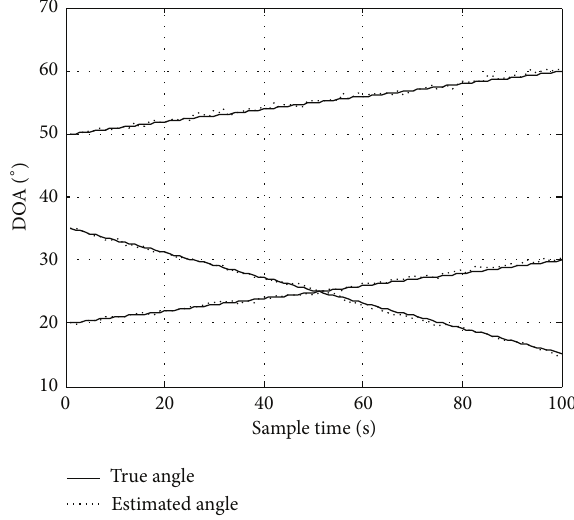
Figure 4: DOA tracking results of the proposed algorithm at SNR = 15 dB (Scene